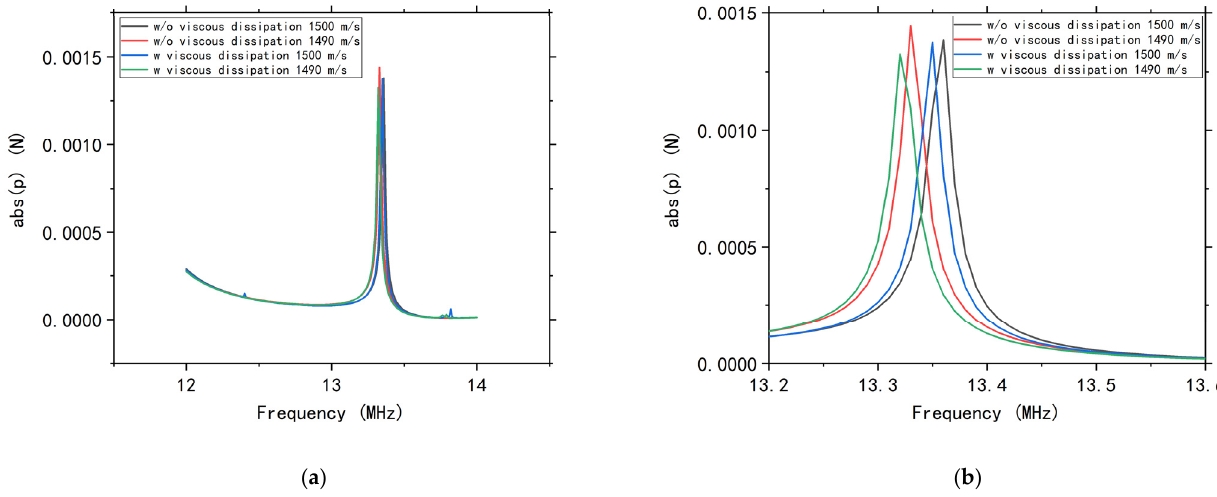
Figure 9. Comparison of the frequency shift caused by sound velocity change and viscous dissipation. ( a ) Response in the range of 12 − 14 MHz. ( b ) Response for the range of 13.2 − 13.6 MHz.